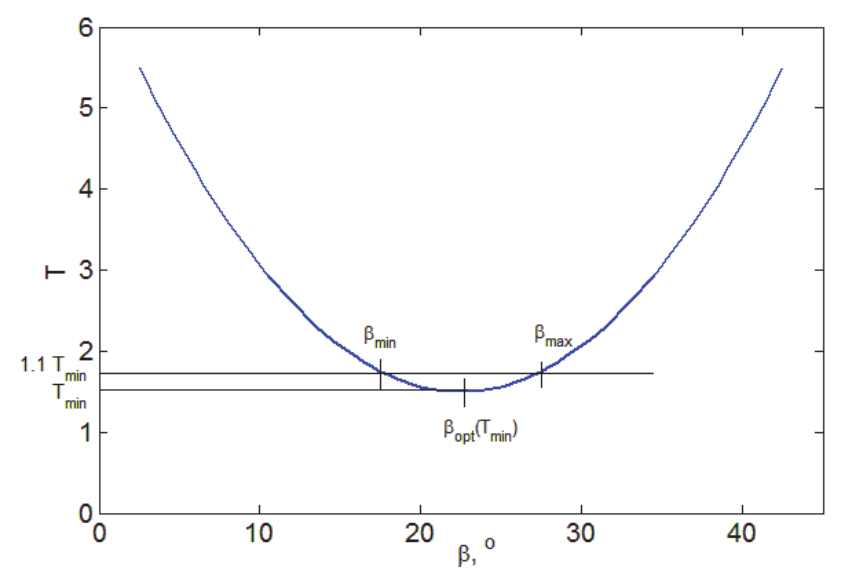
Figure 2: The methodology of presented calculations.